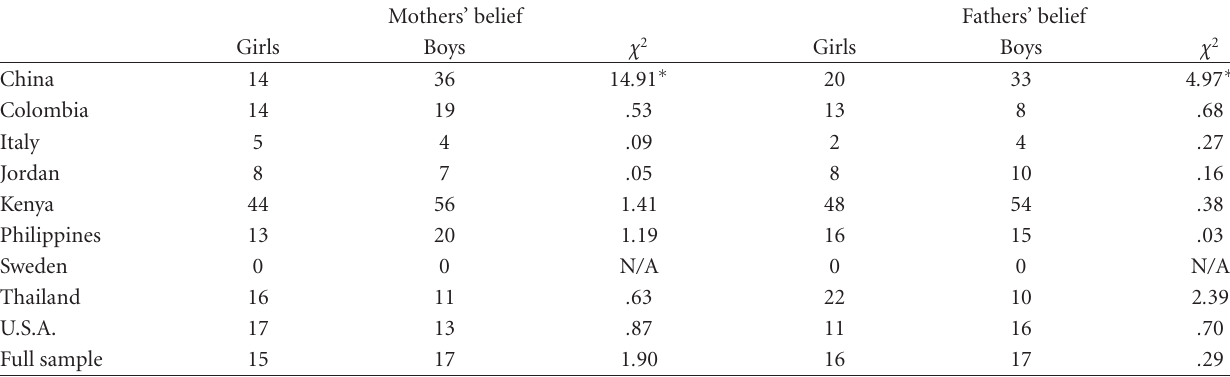
Table 2: Percentages of parents reporting belief that corporal punishment is necessary to rear the target child. Mothers’